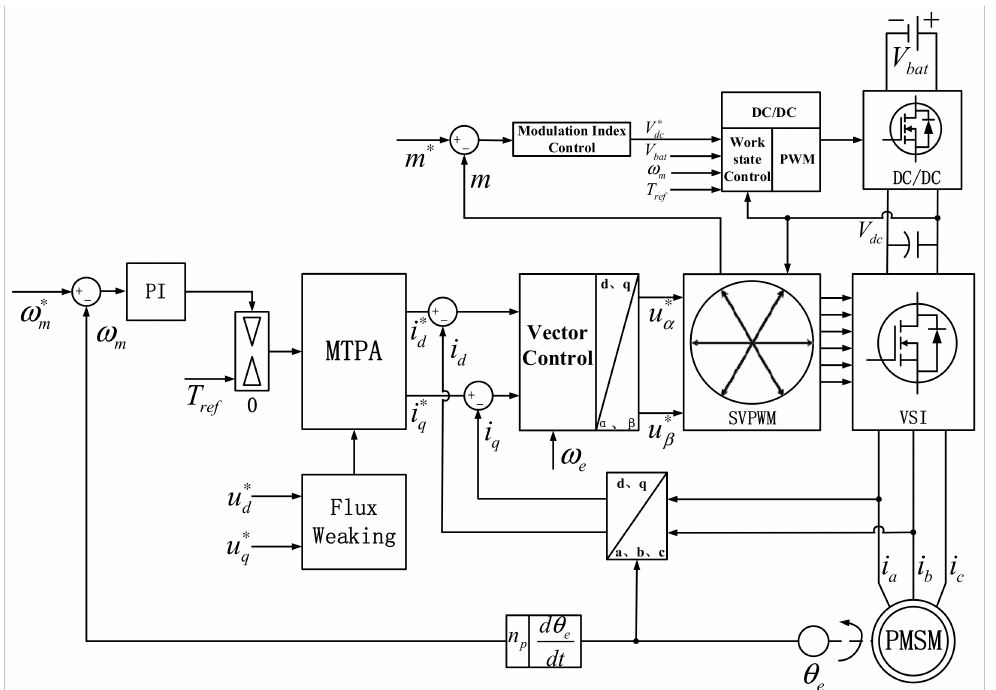
Figure 6. Block diagram of the control strategy for motor drive topology with integrated bidirectional